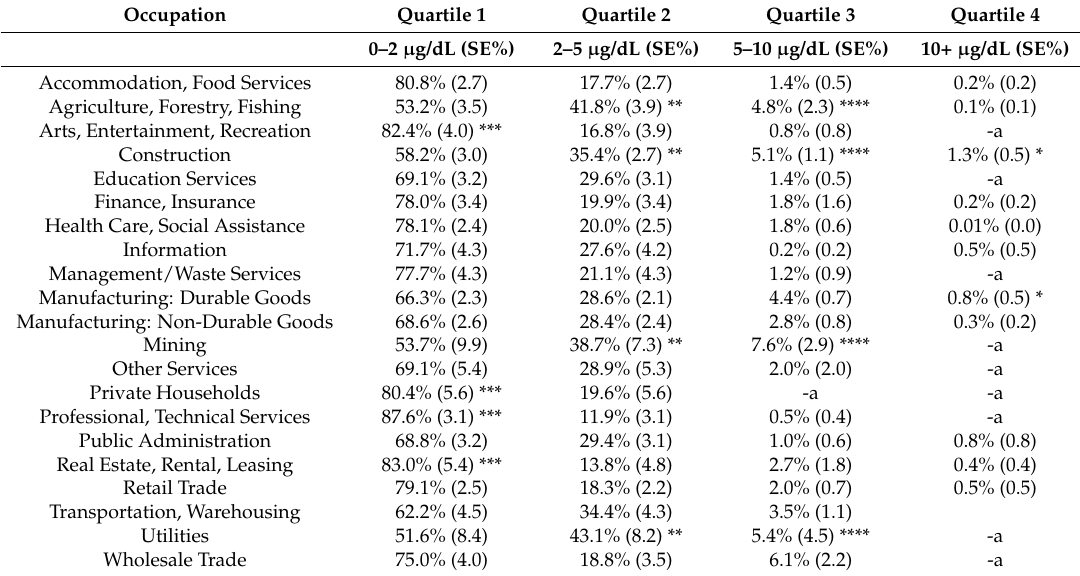
Table 3. Longest held occupation and quartiles of exposure.